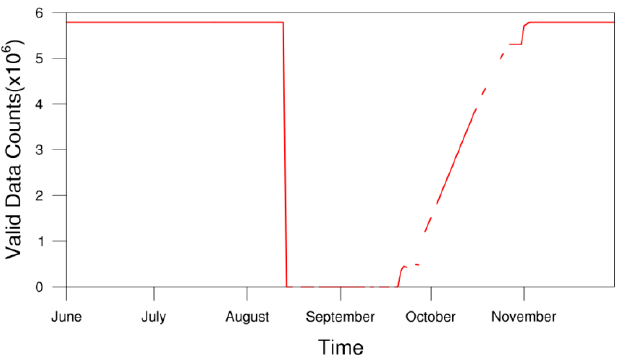
Figure 3. Valid data counts of Fengyun-4B/AGRI 3.75 μ m channel from June to November 2022. The standard deviations of the Fengyun-4B/AGRI 3.75 μ m brightness temperature